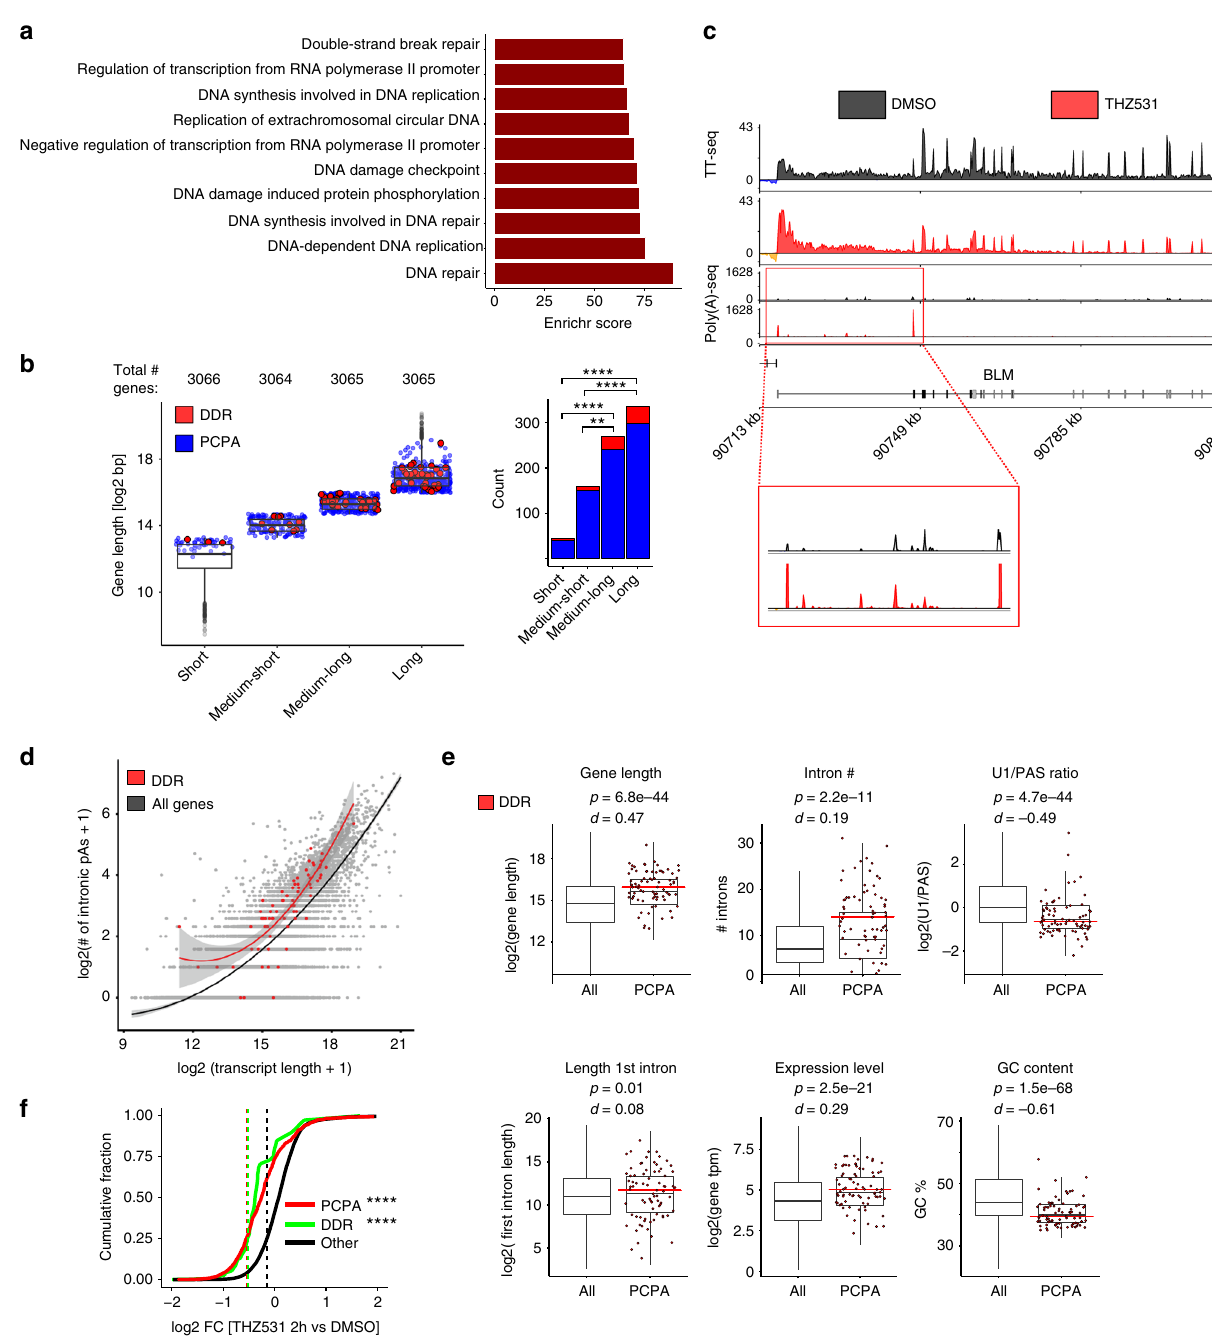
Fig. 5 Gene length and a lower U1/PAS ratio predispose DDR genes to PCPA. a GO enrichment analysis of the 809 genes that underwent PCPA (FDR < 0.01) based on TT-seq analysis of cells treated with THZ531 (400 nM for 2 h). b Box plots and bar plots showing the distribution and numbers of PCPA and DDR genes in the different gene-length categories established in Fig. 2d (**** p < 0.0001, ** p < 0.01, Fisher ’ s exact test). The center line indicates the median for each data set. c TT-seq and poly(A) 3 ′ -seq tracks at the BLM DDR gene locus depicting the loss of annotated terminal polyadenylation signal and the presence of early termination due to PCPA in cells treated with THZ531 as in a . d Number of intronic poly(A) sites as a function of transcript length. A polynomial regression curve is plotted for all genes (black) and DDR genes only (red) ( p = 1.7e − 13, predicted vs. observed, Wilcoxon rank-sum test). e Box plots comparing the indicated determinants of PCPA in all genes vs. PCPA genes only and the proportion of DDR genes within the latter subset (see fi gure for p and d values; Wilcoxon rank-sum test & Cohen ’ s d effect-size, respectively). The black and red center lines indicate the median of all PCPA and DDR genes respectively. f Cumulative fraction plot showing the change in expression of PCPA ( p = 2.2e − 16, Kolmogorov-Smirnov test) and DDR ( p